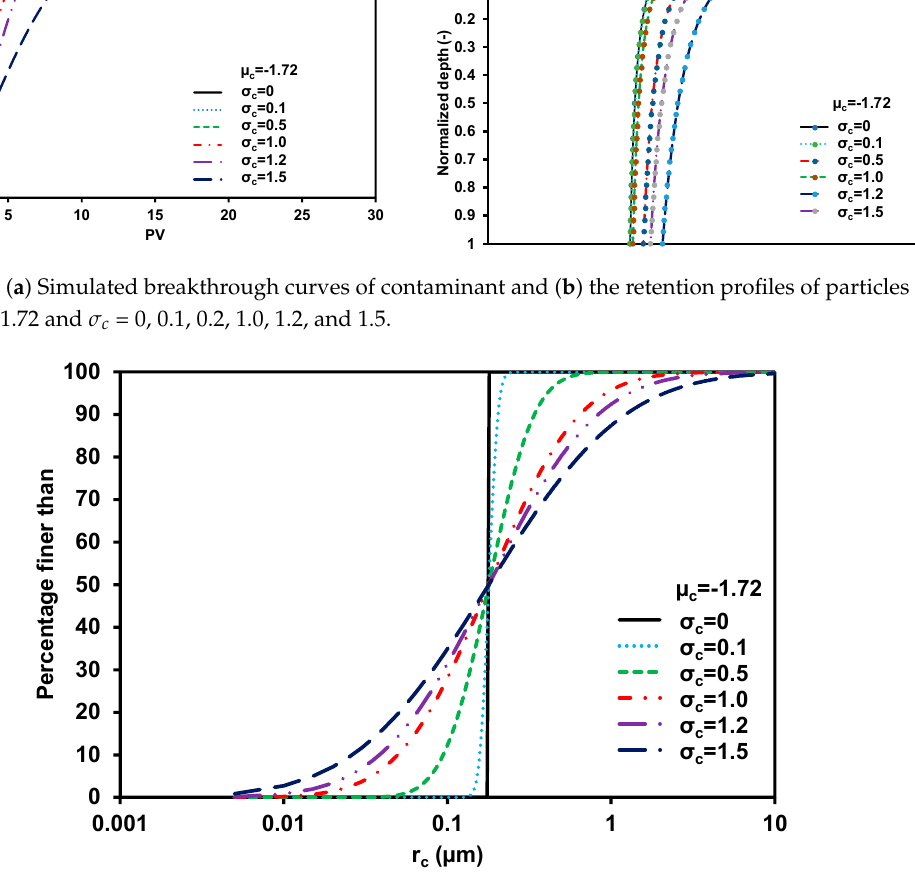
Figure 6. Particle size distributions for colloidal particles ( µ c = − 1.72) used in the simulation.